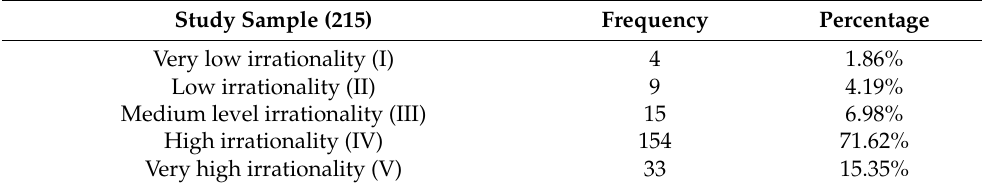
Table 3. Frequency and percentage of subjects included in the study according to irrationality classes.